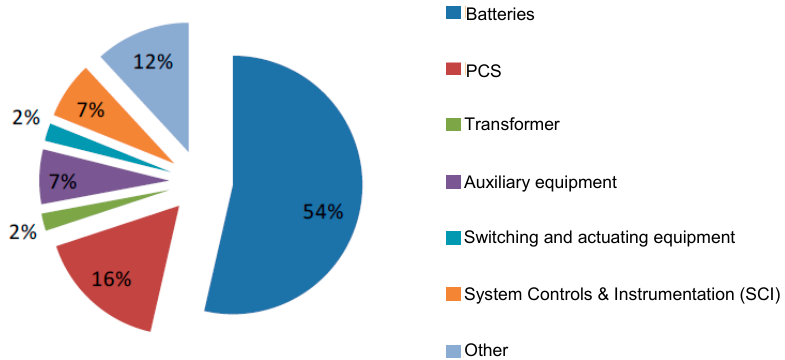
Figure 12. Li-ion percentage costs.